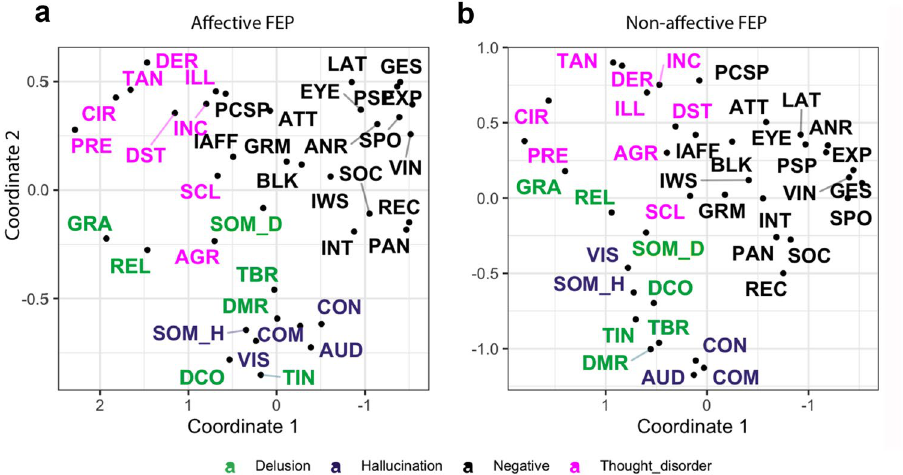
Figure 4. MDS solution for subgroups of FEP sample. ( a ) MDS solution for participants with an Affective FEP and ( b ) Non-affective FEP diagnosis. CON: voices conversing, COM: voices commenting, SOM_H: